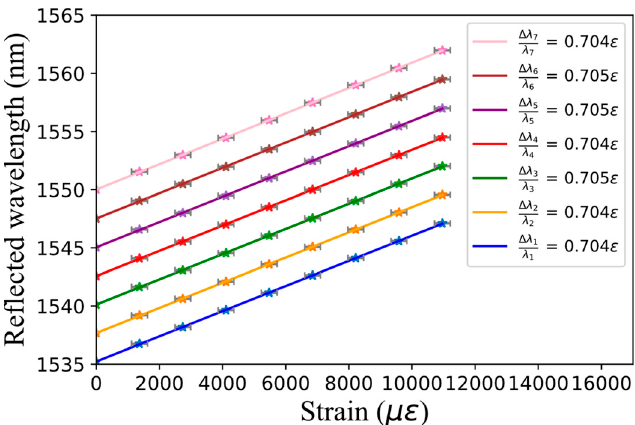
Figure 12. Reflected wavelength as a function of strain for all seven FBGs of the array presented in Figure 11.